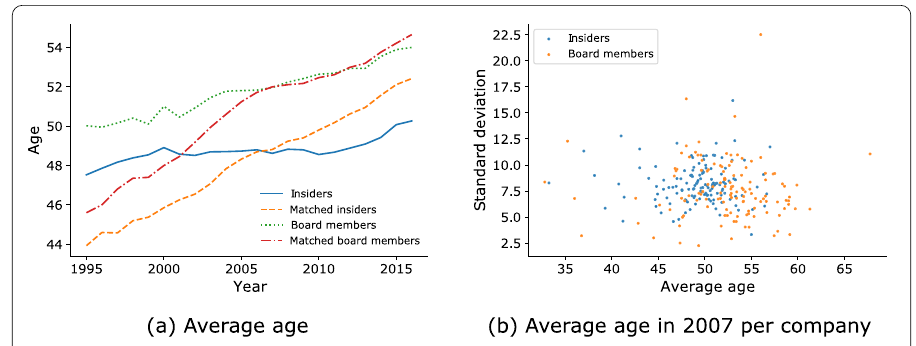
Figure 11 Age of insiders and board members. ( a ) Average age of company insiders, matched insiders, board members, and matched board members. ( b ) Average age of insiders and board members for 132 companies in